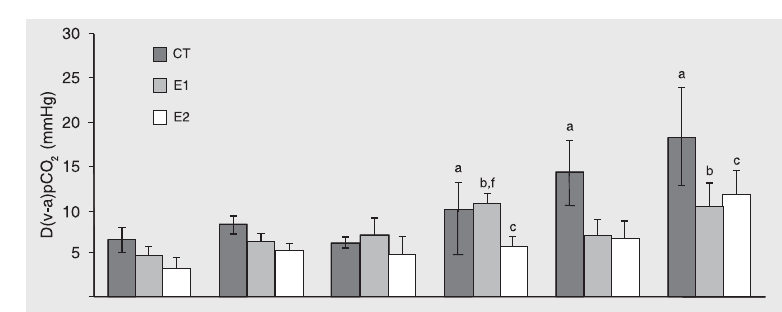
Figure 4. D(v-a)pCO 2 gradient (mmHg, mean ± SEM) and D(p-a)pCO 2 gradient (mmHg, mean ± SEM) during the experimental protocol. CT (control, N = 4) = fluid resuscitation (T30-T60) group; E1 (N = 5) = enalaprilat (T30-T90) + fluid resuscitation (T90-T120) group; E2 (N = 5) = fluid resuscitation (T30-T60) + enalaprilat (T60-T120) group. D(v-a)pCO 2 = difference between mixed venous pCO 2 and arterial pCO 2 ; D(p-a)pCO 2 = difference between portal vein pCO 2 and arterial pCO 2 . a CT, P < 0.05 vs T0; b E1, P < 0.05 vs T0; c E2, P < 0.05 vs T0; d P < 0.05 CT vs E1; e P < 0.05 CT vs E2; f P < 0.05 E1 vs E2